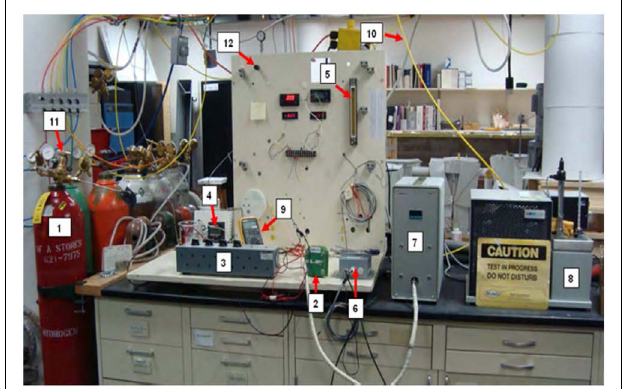
FIGURE 4 | Experimental setup